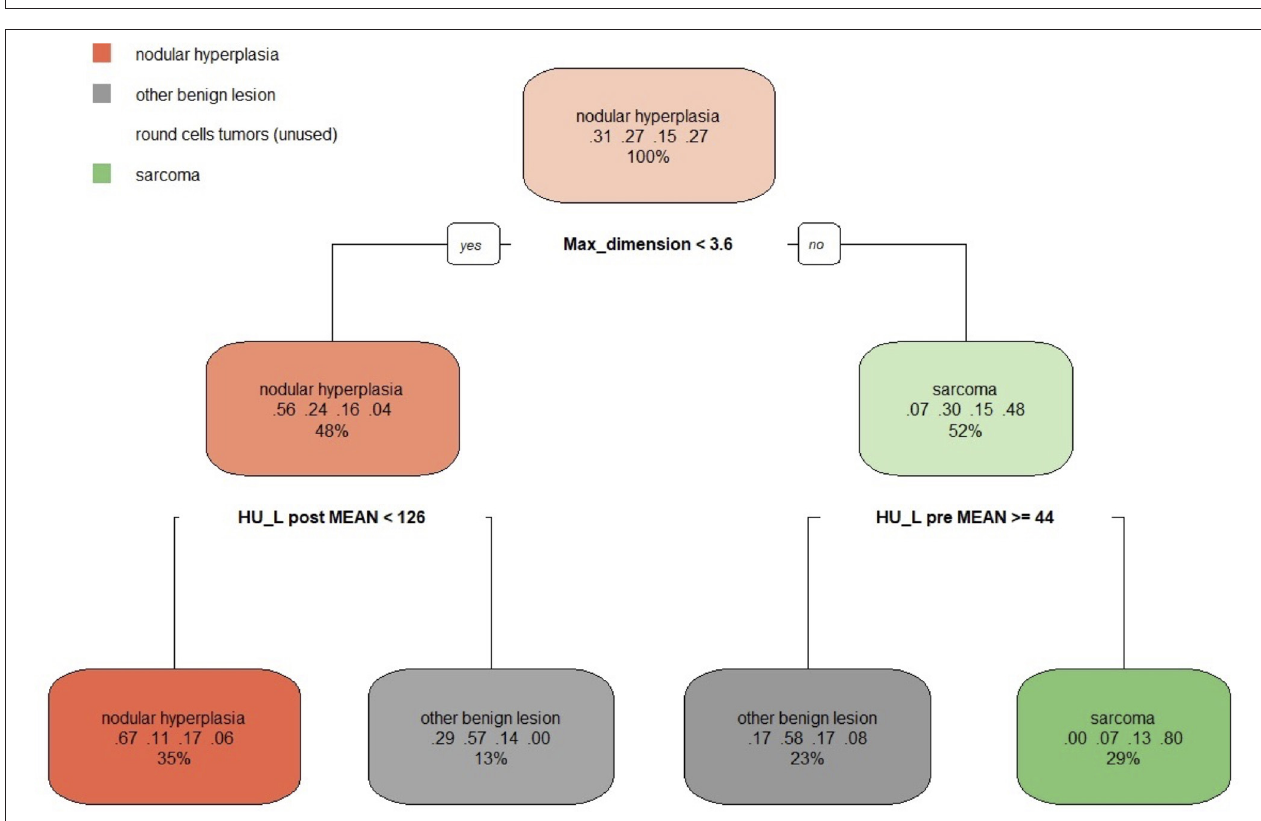
FIGURE 6 | Distribution of the cases (A) and of the centroids (B) based on the F1 and F2 components of the factorial discriminant analysis classification.